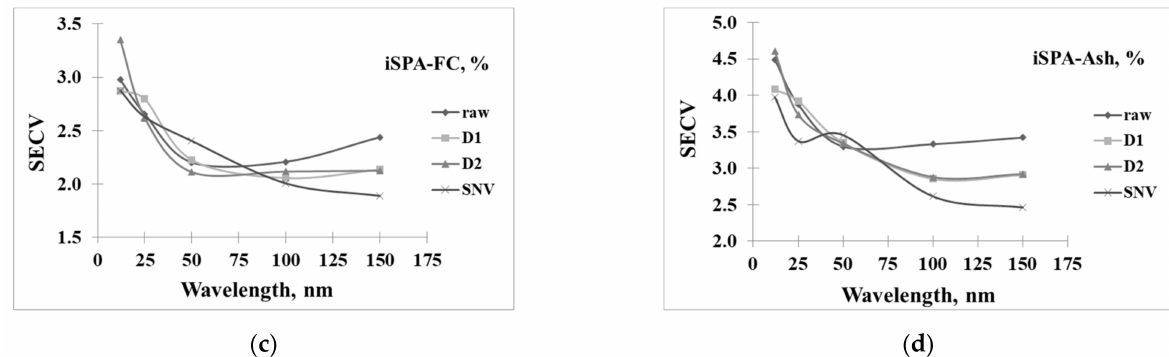
Figure 6. Wavelength selected by iSPA for 12, 25, 50, 100, and 150 wavelengths in prediction of ( a ) fuel ratio (FR, %), ( b ) volatile matter (VM, %), ( c ) fixed carbon (FC, %), and ( d ) ash content (A, %).